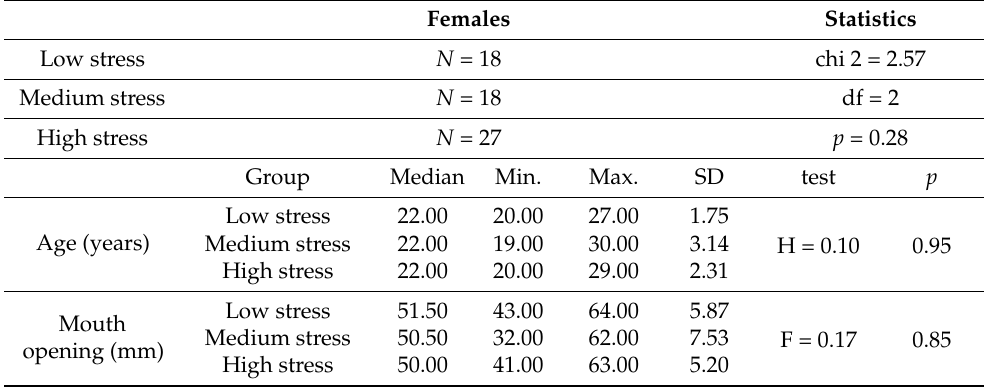
Table 1. Group comparisons according to age, maximum mouth opening and number of participants.